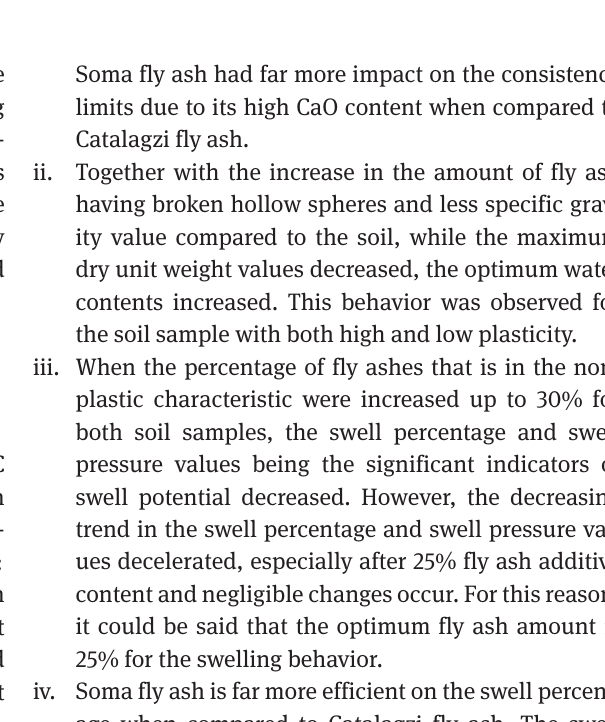
Figure 11: Effect of fly ash contents on unconfined compressive strength of mixtures (A) Soil A-CFA mixtures, (B) Soil A-SFA mixtures, (C) Soil B-CFA mixtures and (D) Soil B-SFA